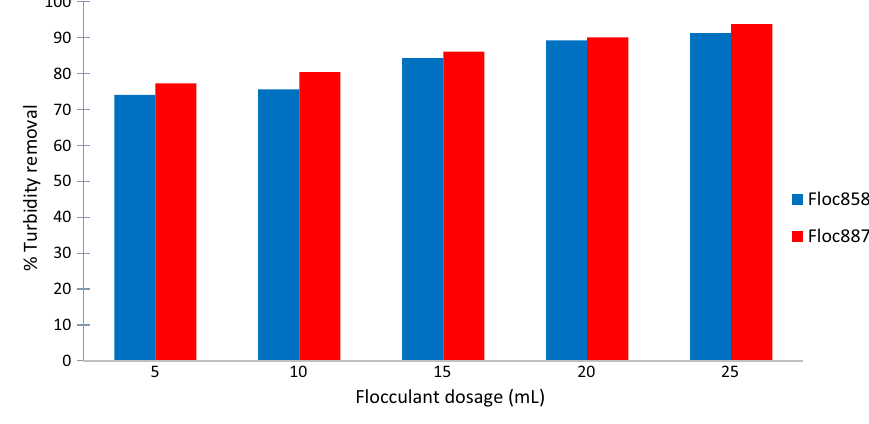
Fig. 3 Turbidity removal efficiencies of flocculants in combination with